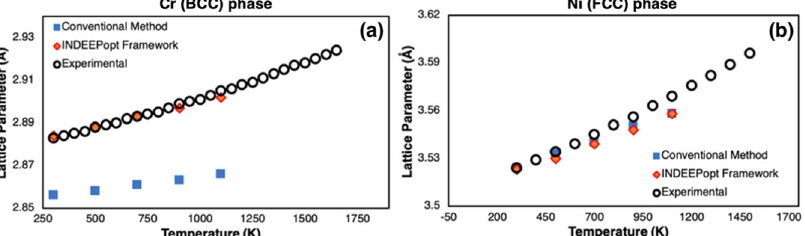
Fig. 7 In fl uence of temepature to lattice parameters for Cr (BCC) and Ni (FCC) phases. The lattice expansion with respect to temperature change for Cr (BCC) phase ( a ) and Ni (FCC) phase ( b ). The experimentally obtained results are compared with the ones obtained using conventionally optimized force fi eld (blue) and INDEEDopt optimized force fi eld